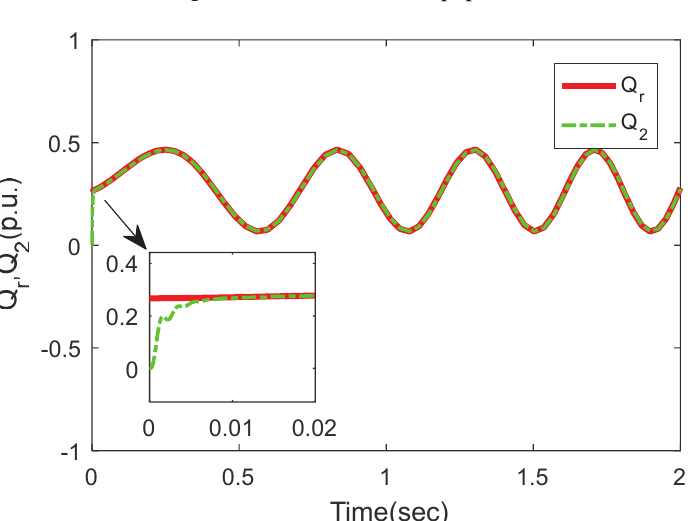
Figure 13. P 2 and P r in this paper.